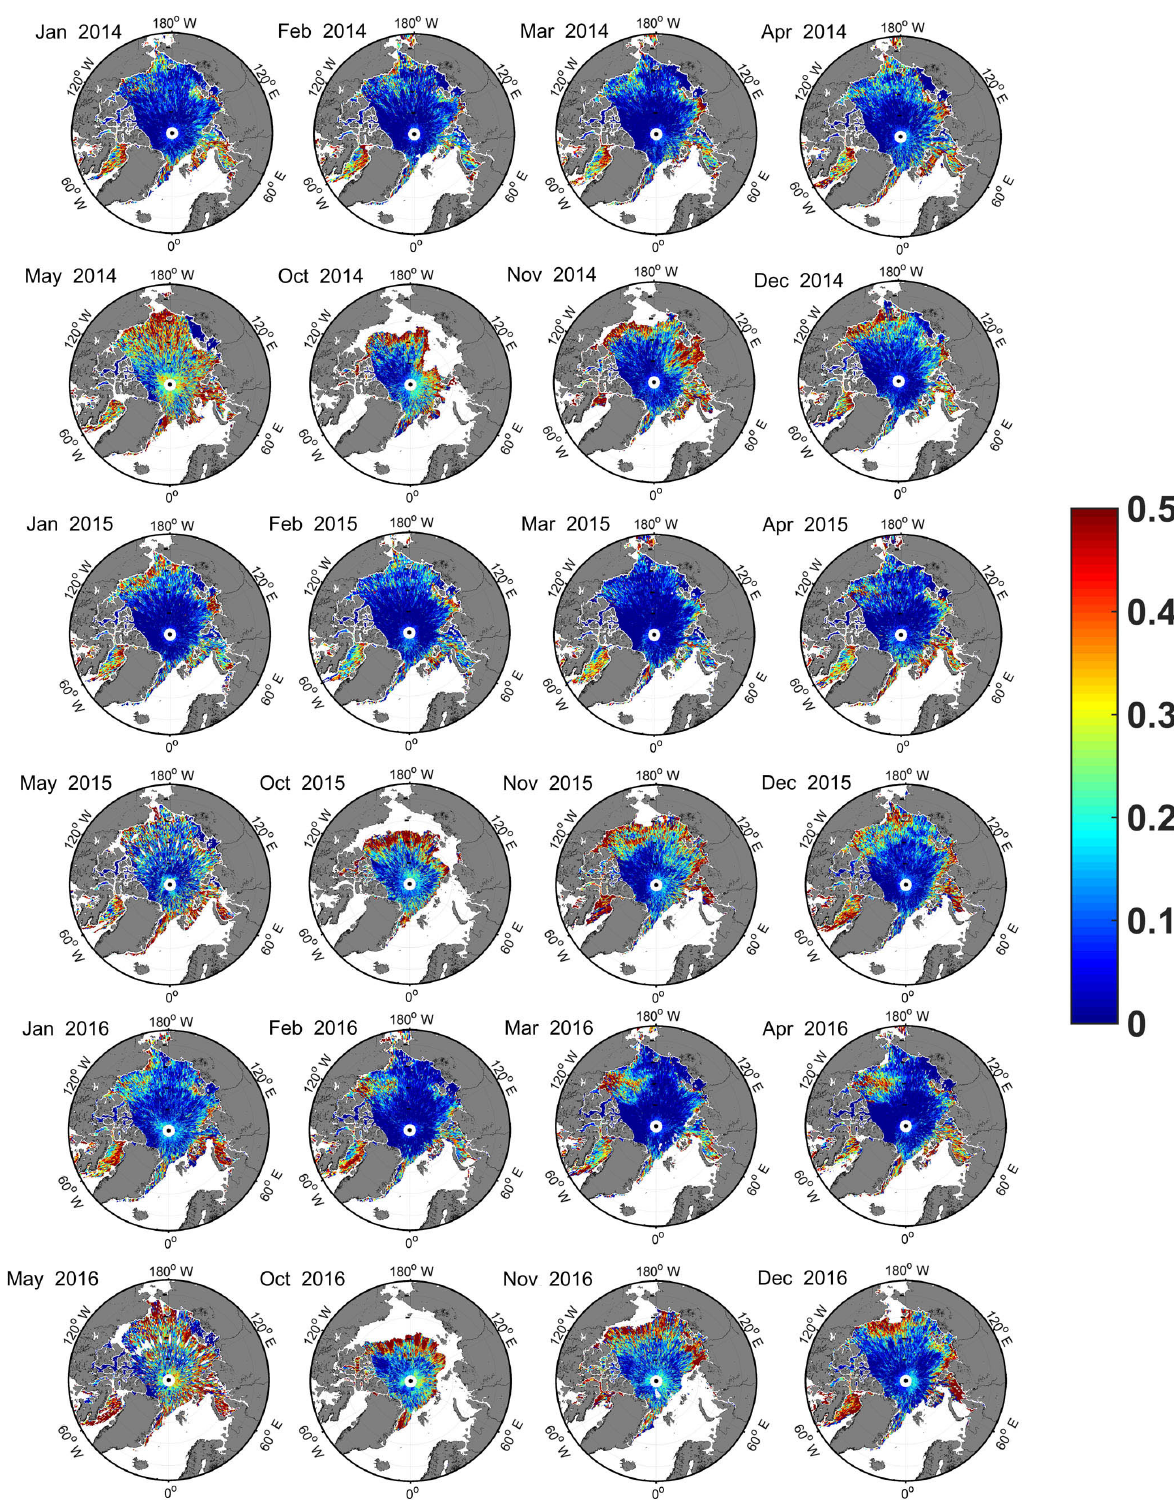
Figure 7. Monthly lead fraction maps based on the waveform mixture algorithm from January to May and October to December between 2014 and 2016. The range of the color bar was set from 0 to 0.5 to emphasize lower